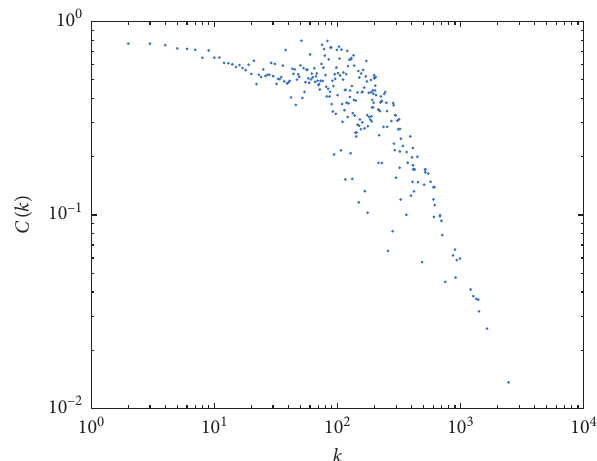
Figure 4: The scaling of C ( k ) with k in traditional Chinese cultural element network.